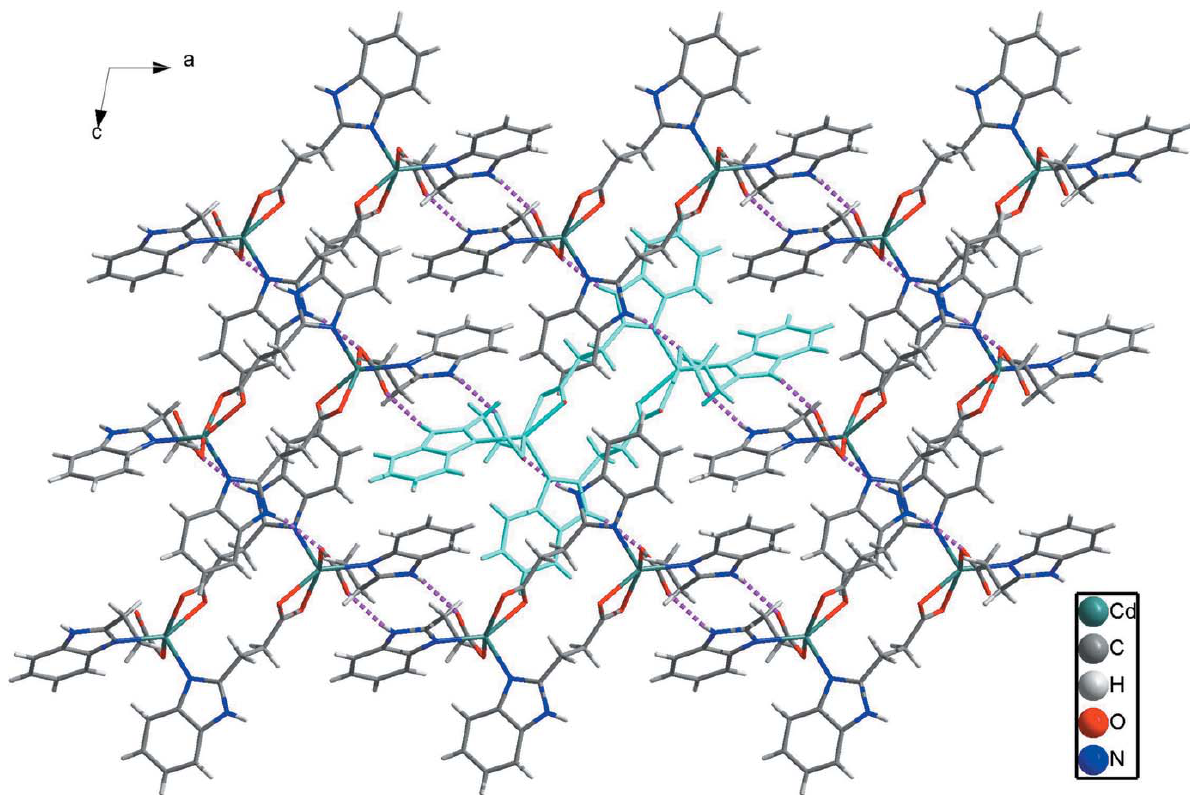
Figure 6 A perspective view of the three-dimensional frameworks in 2 formed by one-dimensional ladders and N—H (cid:4)(cid:4)(cid:4) O hydrogen bonds (Table 3). The hydrogen bonds are shown as dashed